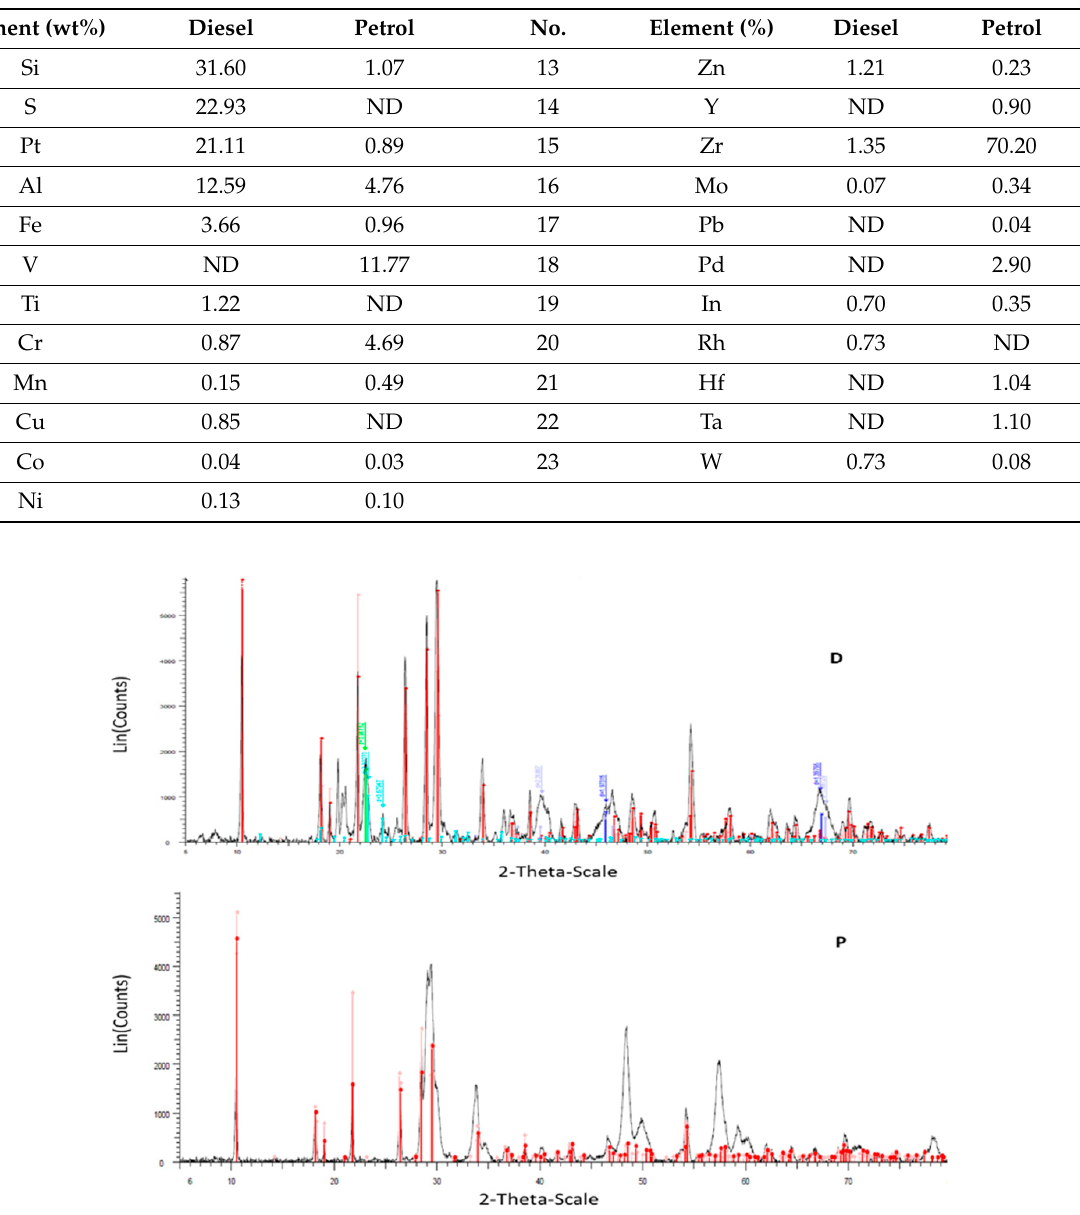
the characteristic reflections of the cordierite with the orthorhombic phase Mg 2 (Al 4 Si 5 O 18 ) (Figure 3) [43]. The diesel sample showed the cordierite phase as a major component (red) but with minor phases of aluminium phosphate hydrate (turquoise), aluminium oxide (blue), gamma-alumina (light blue), aluminium silicate (green). PGMs phases would be too small to be determined singly by XRD and the cordierite is the dominant phase that would overshadow them. Table 1. The main constituents of the catalysts were obtained with XRF analysis.